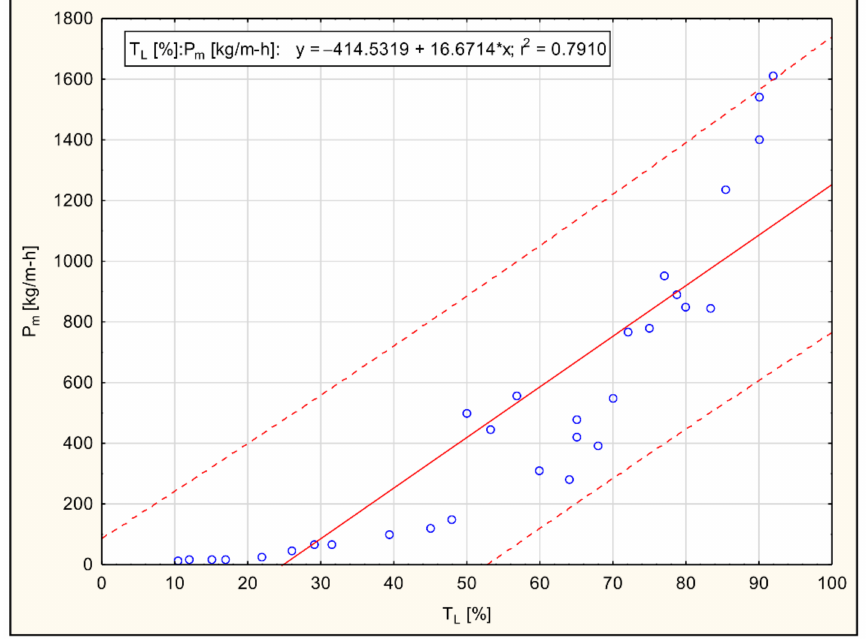
Figure 4. Changes in the milkman’s mass productivity (P m ) with an increase in the technological index level (T L